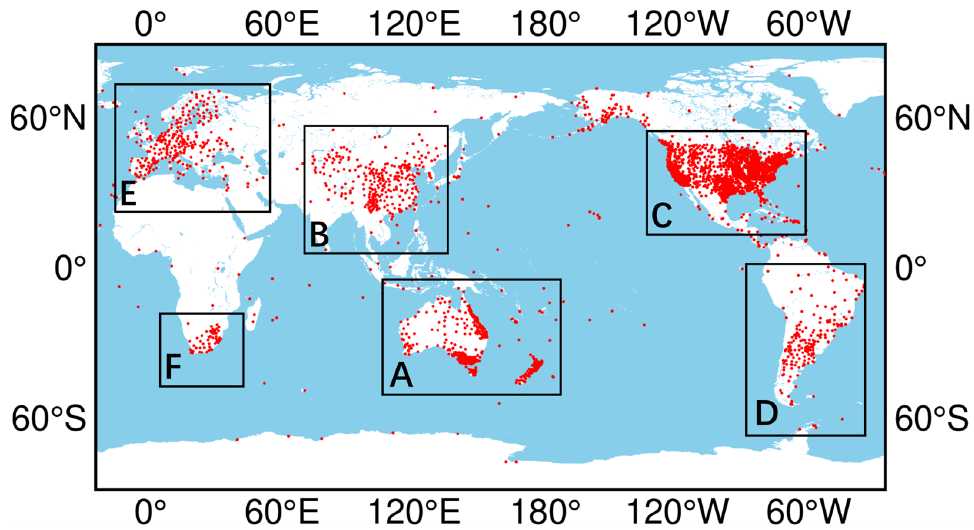
Figure 1. Over 3000 GPS stations worldwide are involved in disturbance wave analysis: New Zea- land and Australia ( A ), China ( B ), US mainland ( C ), South America ( D ), Europe ( E ), South Africa ( F ).